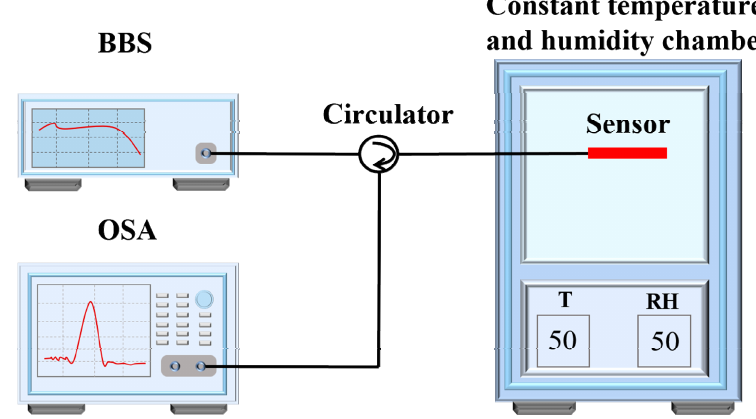
Figure 7. Schematic diagram of the temperature and humidity response experiment test.